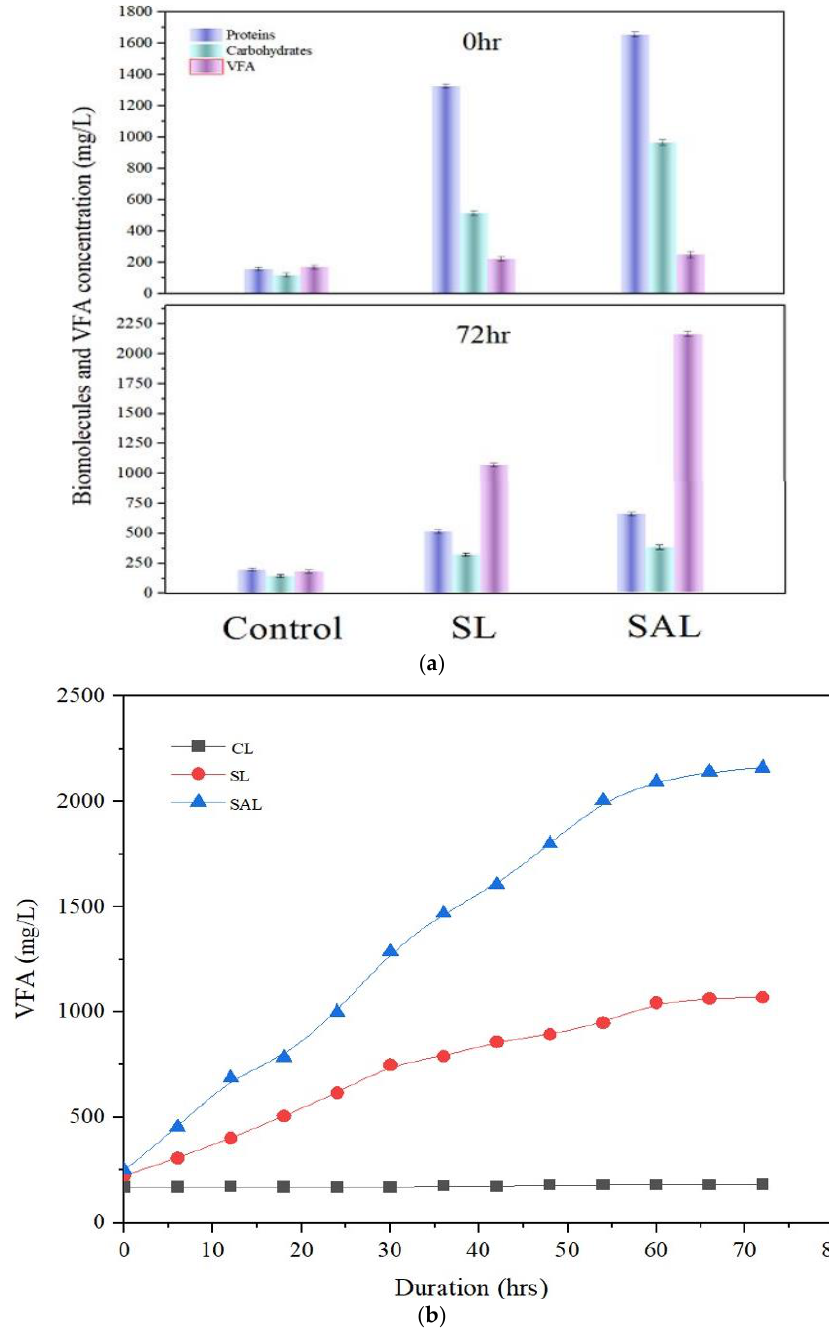
Figure 4. ( a ) VFA generation in CL, SL and SAL. ( b ) Hourly variations in CL, SL and SAL. This demonstrated the efficiency of synergetic pretreatment by proving that highly liquefied biomolecules were readily available to fermentative bacteria [44]. This is equiv- alent to the work of Gao et al. [45], who proposed a combined approach of hydroxyl rad- ical and thermal pretreatment to improve the biodegradability of algae. Contrarily, the CL